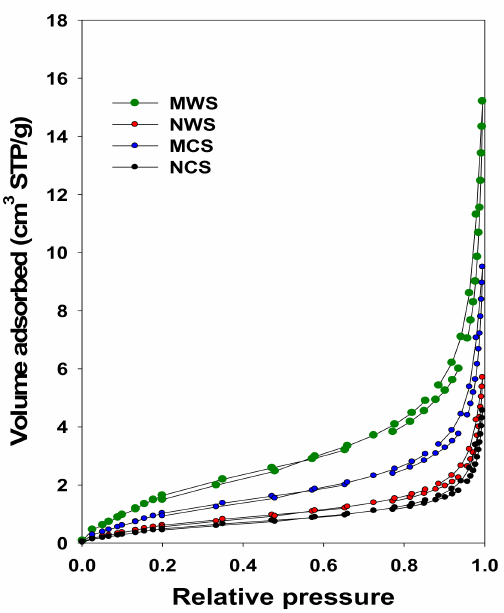
Figure 1. Nitrogen adsorption desorption isotherms for starch samples.